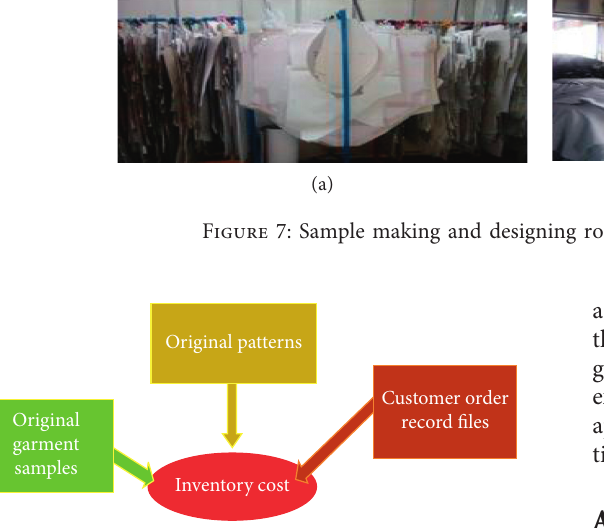
Figure 8: Manufacturer’s inventory cost